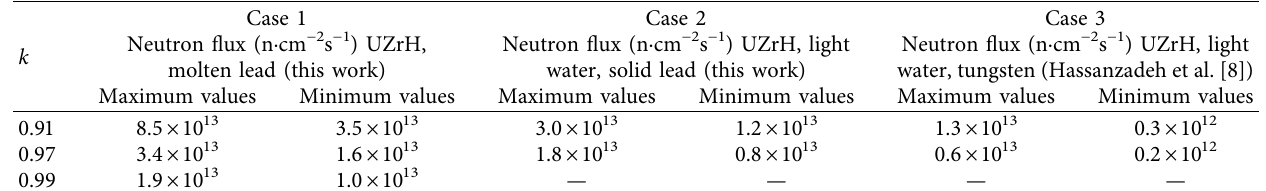
Figure 4: The axial distributions of the neutron flux with UZrH fuel mixture, placed in the molten lead as target and Table 4: Maximum and minimum neutron flux calculated for some configurations, coolant and target.